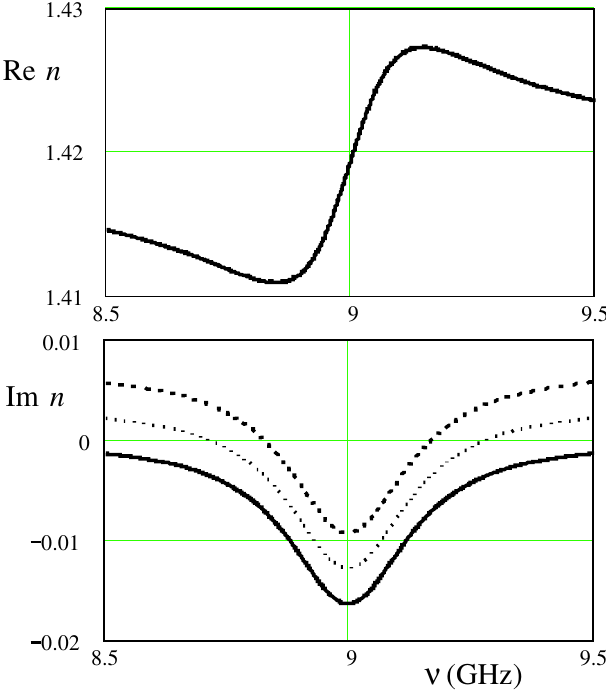
FIG. 2. (Color) Real and imaginary parts of refractive index. Solid, dotted, and dashed curves correspond to Im (cid:4) 0; 0 : 01; 0 : 02